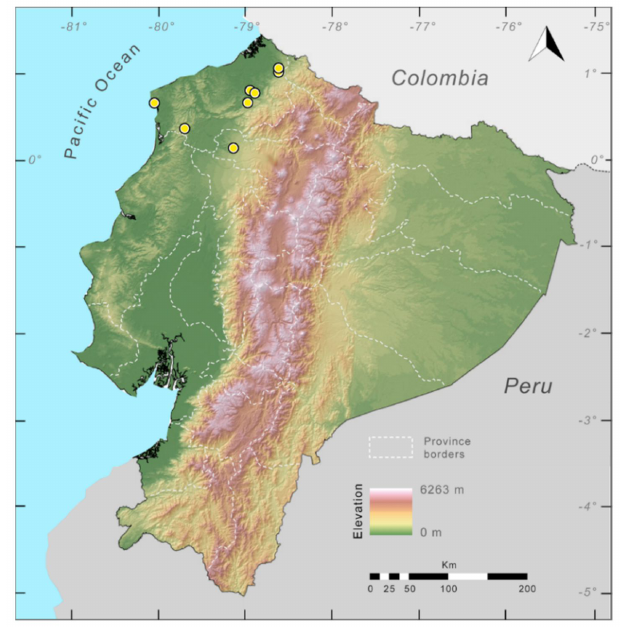
Figure 217. Distribution of Teratohyla pulverata in Ecuador (yellow